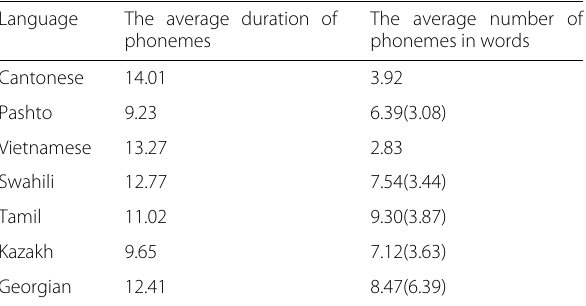
Table 8 The linguistic information of all languages, including the average duration of phonemes and the average number of